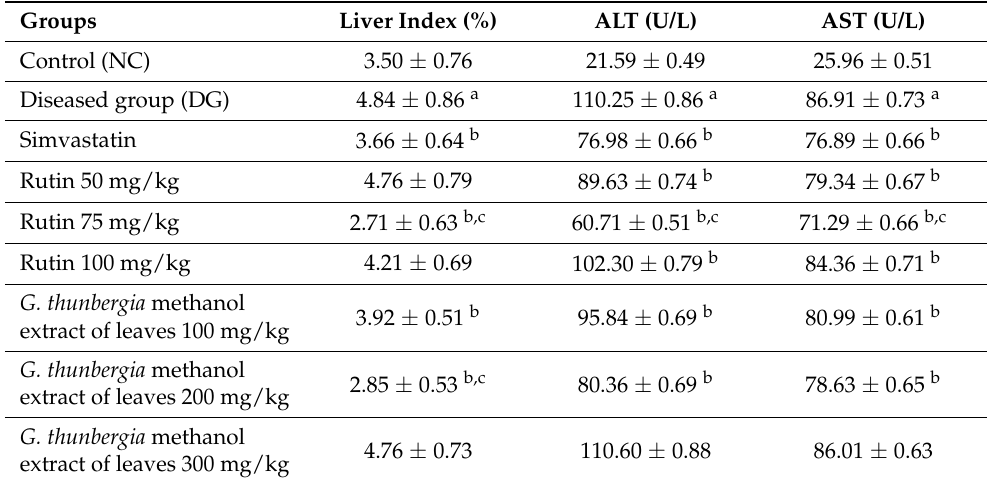
Table 2. Impact of rutin and leaves methanol extract on liver index and liver function tests of mice.